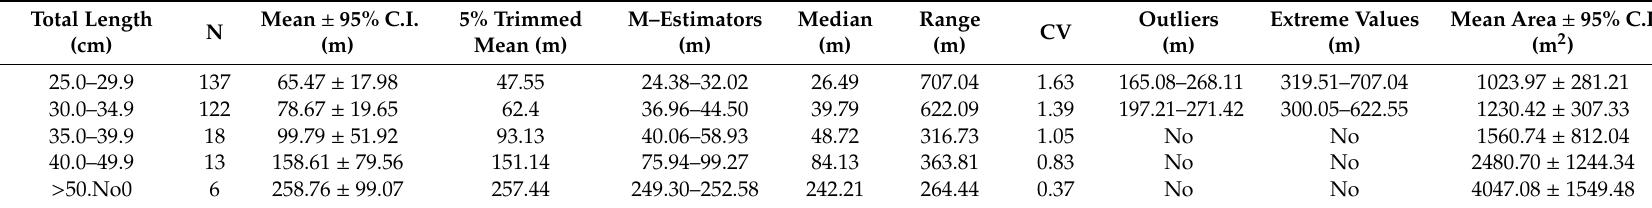
Table 1. Maximum Distance Moved (MDM, home range) descriptive statistics by length intervals (mean body length (total length, TL) of the total number of recaptures) in the studied eel population of the Guadiaro River. Data are from individuals with one or more recaptures. CV = Coe ffi cient of